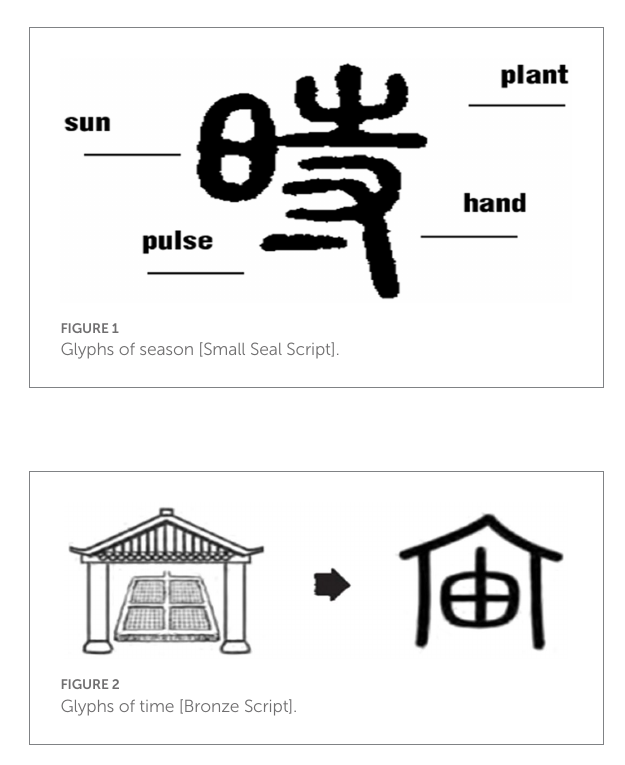
FIGURE 2 Glyphs of time [Bronze